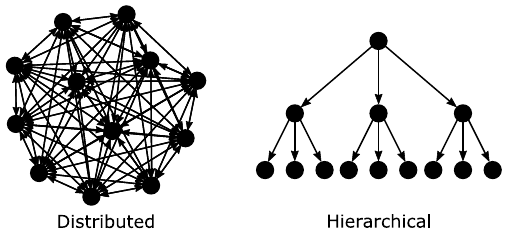
Figure 1. Example groups with distributed (left) and hierarchical (right) organizational